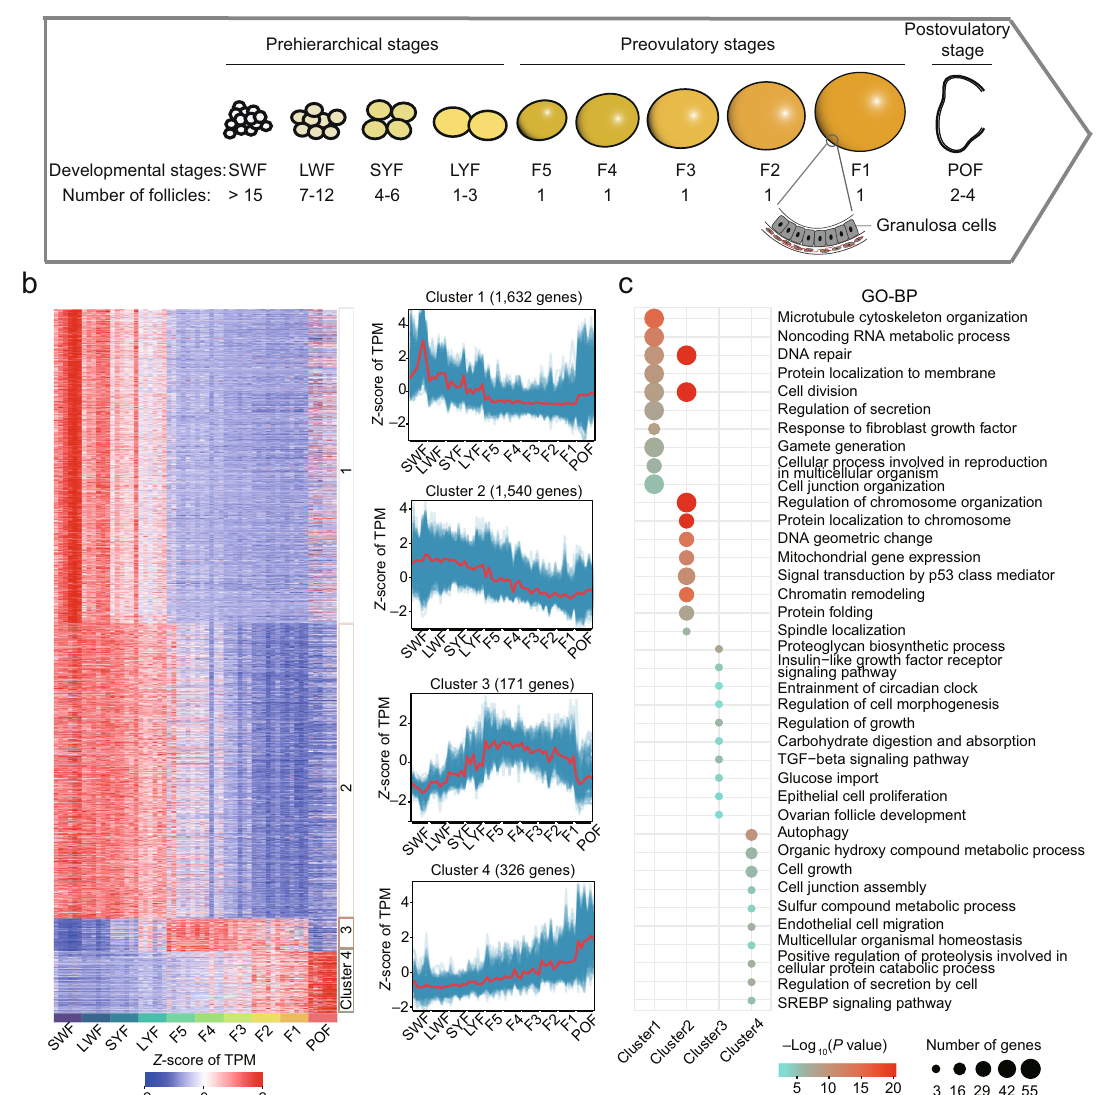
Fig. 1 The transcriptomic pro fi les of granulosa cells (GCs) during folliculogenesis. a Schematics of chicken ovarian follicle development at ten time points during folliculogenesis. The number of follicles for each stage in the chicken ovary is indicated below the stage. GCs in the F1 follicle are indicated on the plot. b Expression pro fi les of four temporal expression clusters revealed by k -means clustering. Left: Expression heatmap drawn using Z -score of TPM values for each gene in the four clusters. Right: Temporal expression pro fi les of the four clusters. The red lines represent mean gene expression levels, and the blue lines represent gene expression levels for each gene in the relative cluster during folliculogenesis. c The top ten signi fi cantly enriched Gene Ontology-Biological Process (GO-BP) terms for genes in each cluster. Source data are provided as a Source Data fi